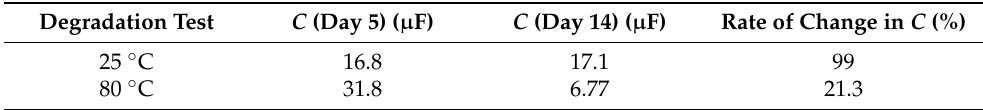
Table 1. Percentage change in C in the 25 ◦ C and 80 ◦ C degradation tests.